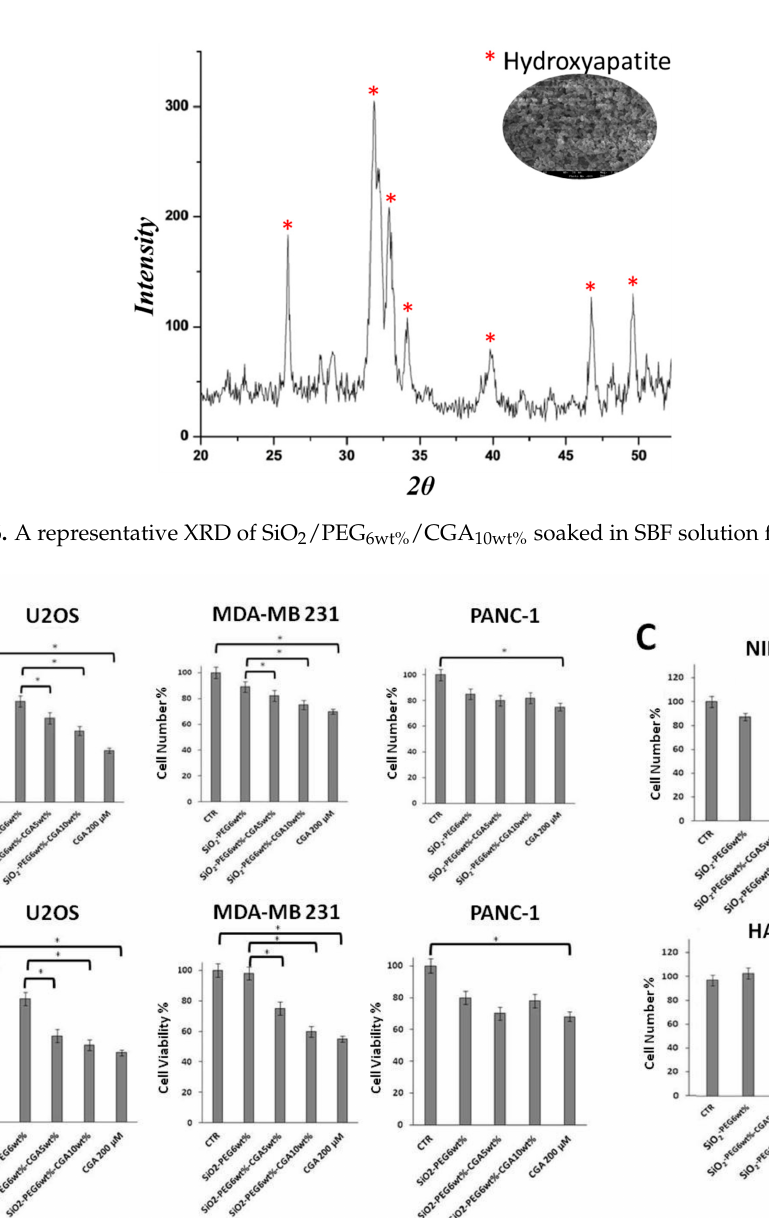
Figure 7. Effects of SiO 2 /PEG hybrid 0.5 mg/mL, SiO 2 /PEG 6wt% /CGA 5wt% hybrid 0.5